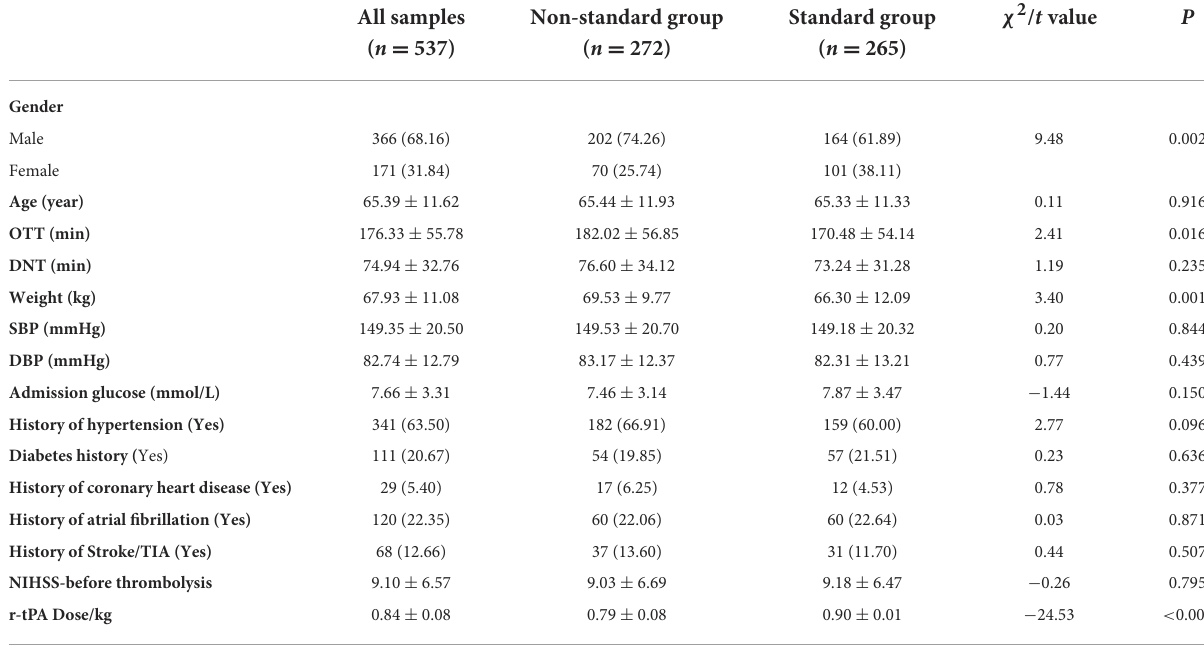
TABLE 1 General information on non-standard group and standard group patients. All samples Non-standard